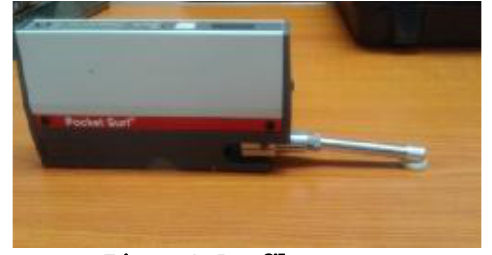
Figure 1: Profilometer Table 3: Descriptive and ANOVA test among the three tested composite